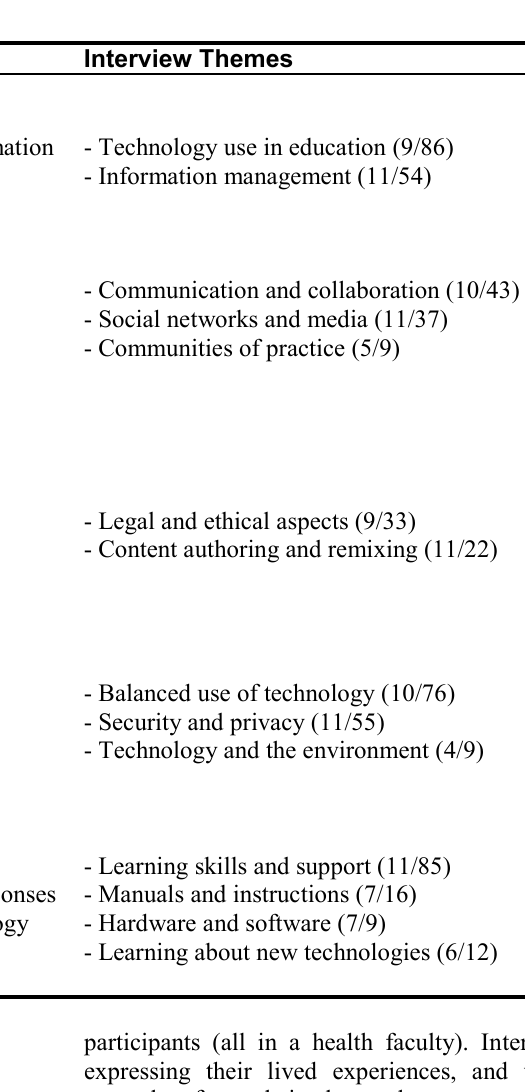
Table 2. Interview Themes Mapped onto the DIGCOMP Framework Areas (Final Version)